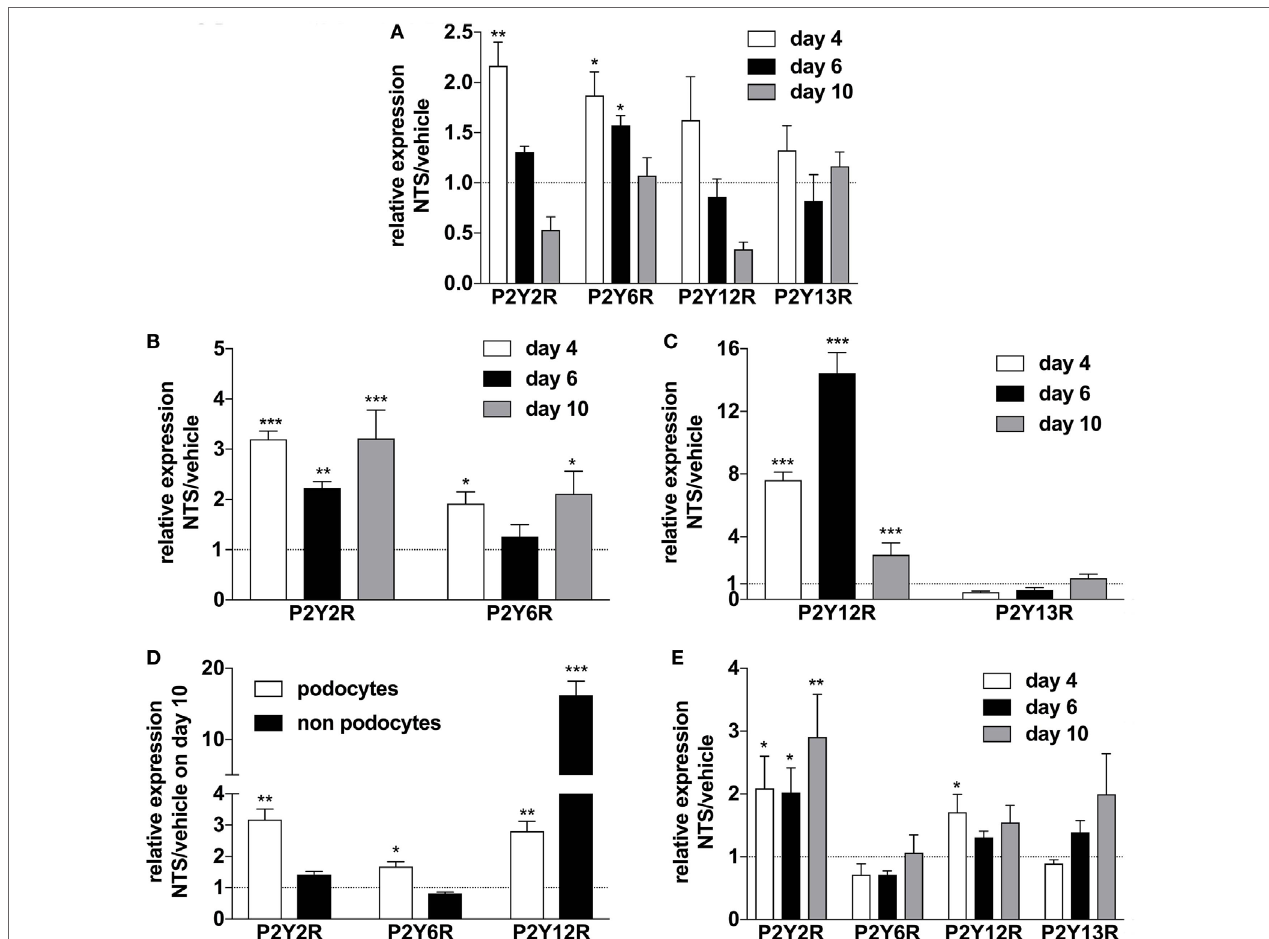
FigUre 4 | Expression of P2YR subtypes on whole kidney tissue, isolated glomerula, isolated podocytes versus non-podocyte glomerular cells, and blood leukocytes following nephrotoxic serum (NTS)-induced glomerulonephritis (GN). C57BL/6 mice received either vehicle (PBS) or NTS (solved in PBS) intravenously on days 1, 2, and 3 to induce GN. For the isolation of podocytes, we used Gt(ROSA)26Sortm4(ACTB-tdTomato,-EGFP)Luo/J mice, which had been crossed with hNPHS2 Cre mice. Podocytes of these mice express GFP while all other cells express Tomato. On days 4, 6, and 10 animals were killed after a blood sample for the isolation of leukocytes had been collected. RNA was isolated from whole kidney tissue, isolated glomerula, isolated podocytes, and non-podocytal glomerular cells and from blood leukocytes. Glomerula were isolated using perfusion with magnetic beads. From the isolated glomerula, we separated the GFP-labeled podocytes from non-podoyctes via FACS. Relative expression of the different P2Y receptors compared to β 2m in triplicates were analyzed using quantitative RT-PCR. (a) Expression of P2YR subtypes on whole kidney tissue from n = 5 animals per group. (B,c) Expression of P2YR subtypes on isolated glomerula from n = 5 animals per group. (D) Expression of P2YR subtypes on isolated podocytes versus non-podocyte glomerular cells from n = 5 animals per group. (e) Expression of P2YR subtypes on isolated blood leukocytes from n = 5 animals per group. Data are shown as mean ± SEM, n = 5 mice in each group. Data from one representative experiment out of three are